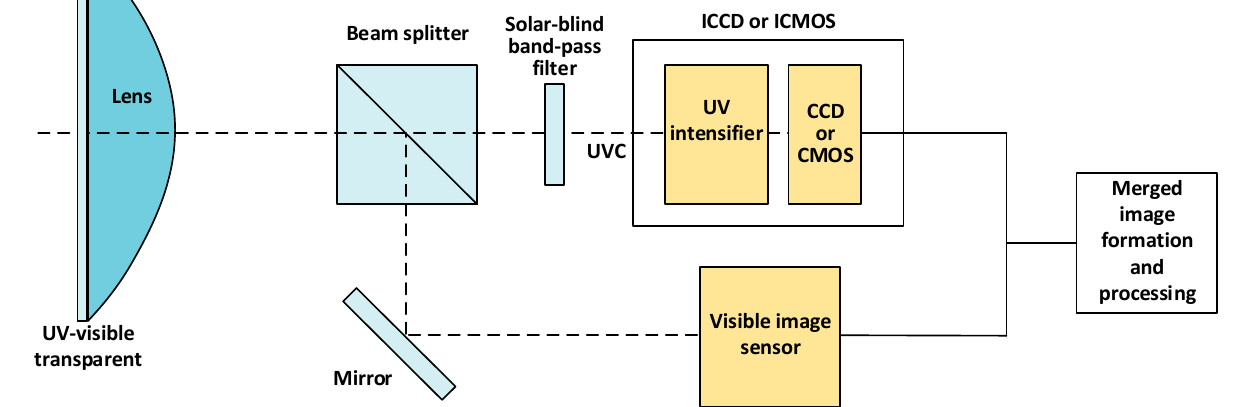
Figure 7. Schematics of UV-visible dual-spectra imager adapted from [109].